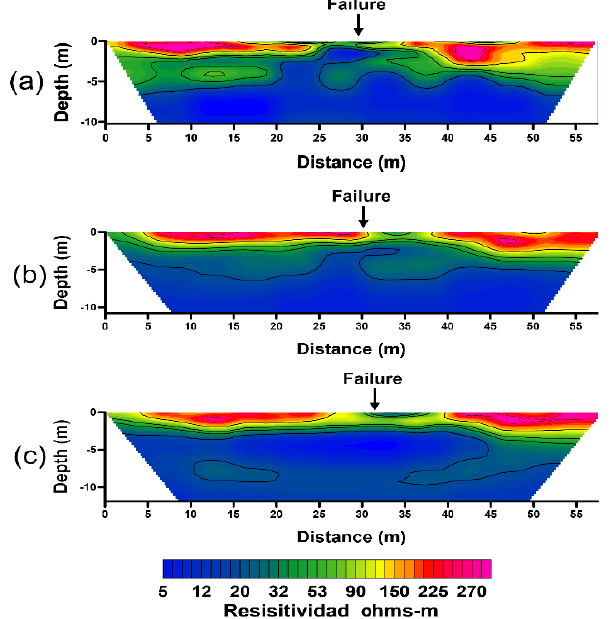
Figure 2. Profiles with 2.5m opening between electrode, (a) Dipole-Dipole, (b) Wenner, (c) Schlumberger.